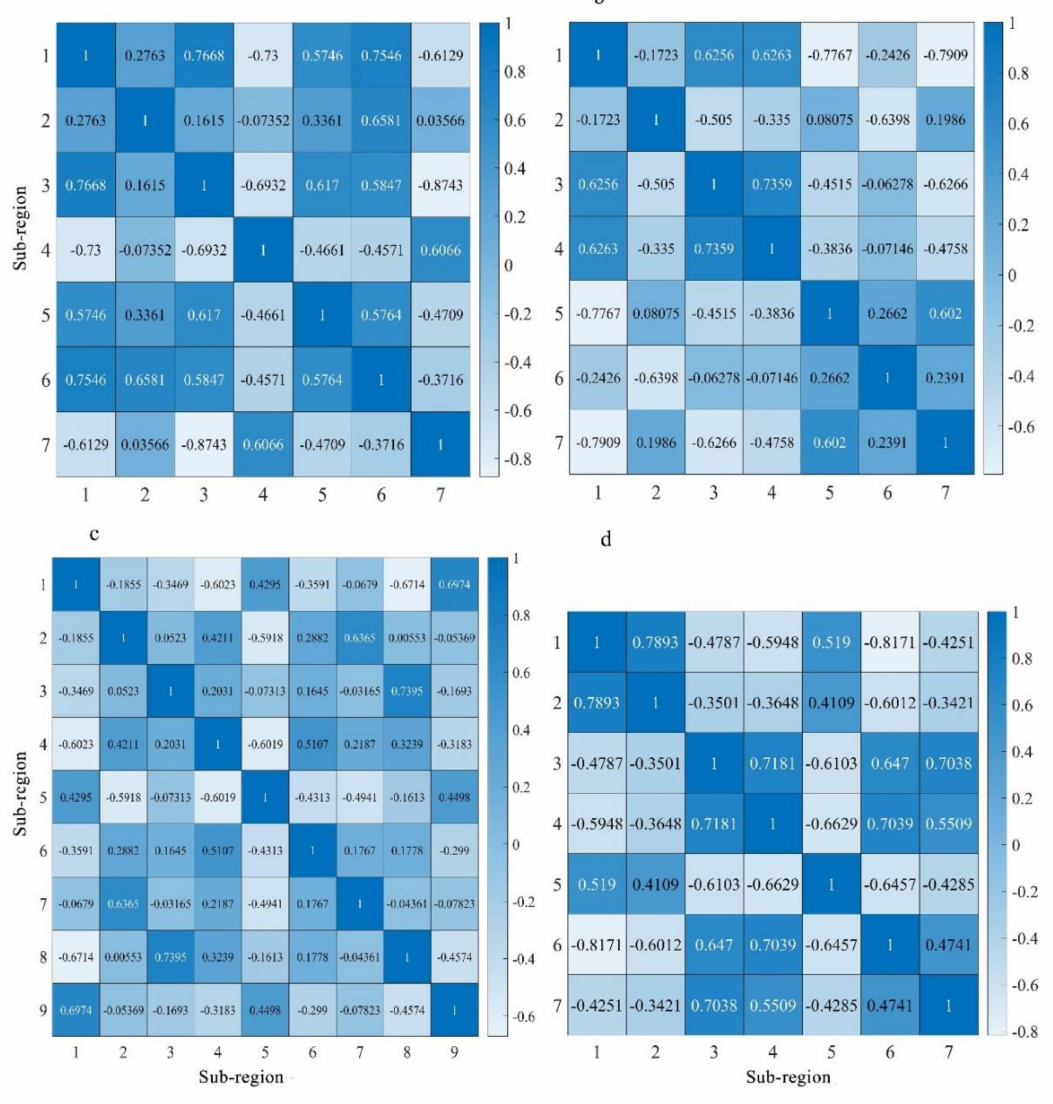
Figure 8. The correlation coe ffi cients between sub-region rPC time series. The symbol ( a – d ) stands for spring, summer, fall, and winter,